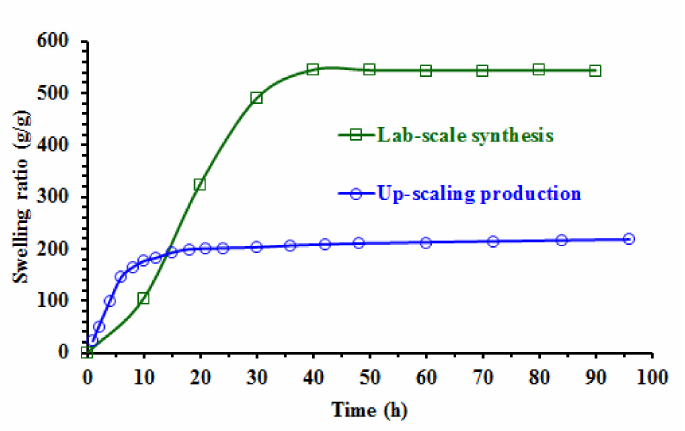
Figure 3. Swelling kinetics of SWA prepared from lab-scale synthesis and up-scaling